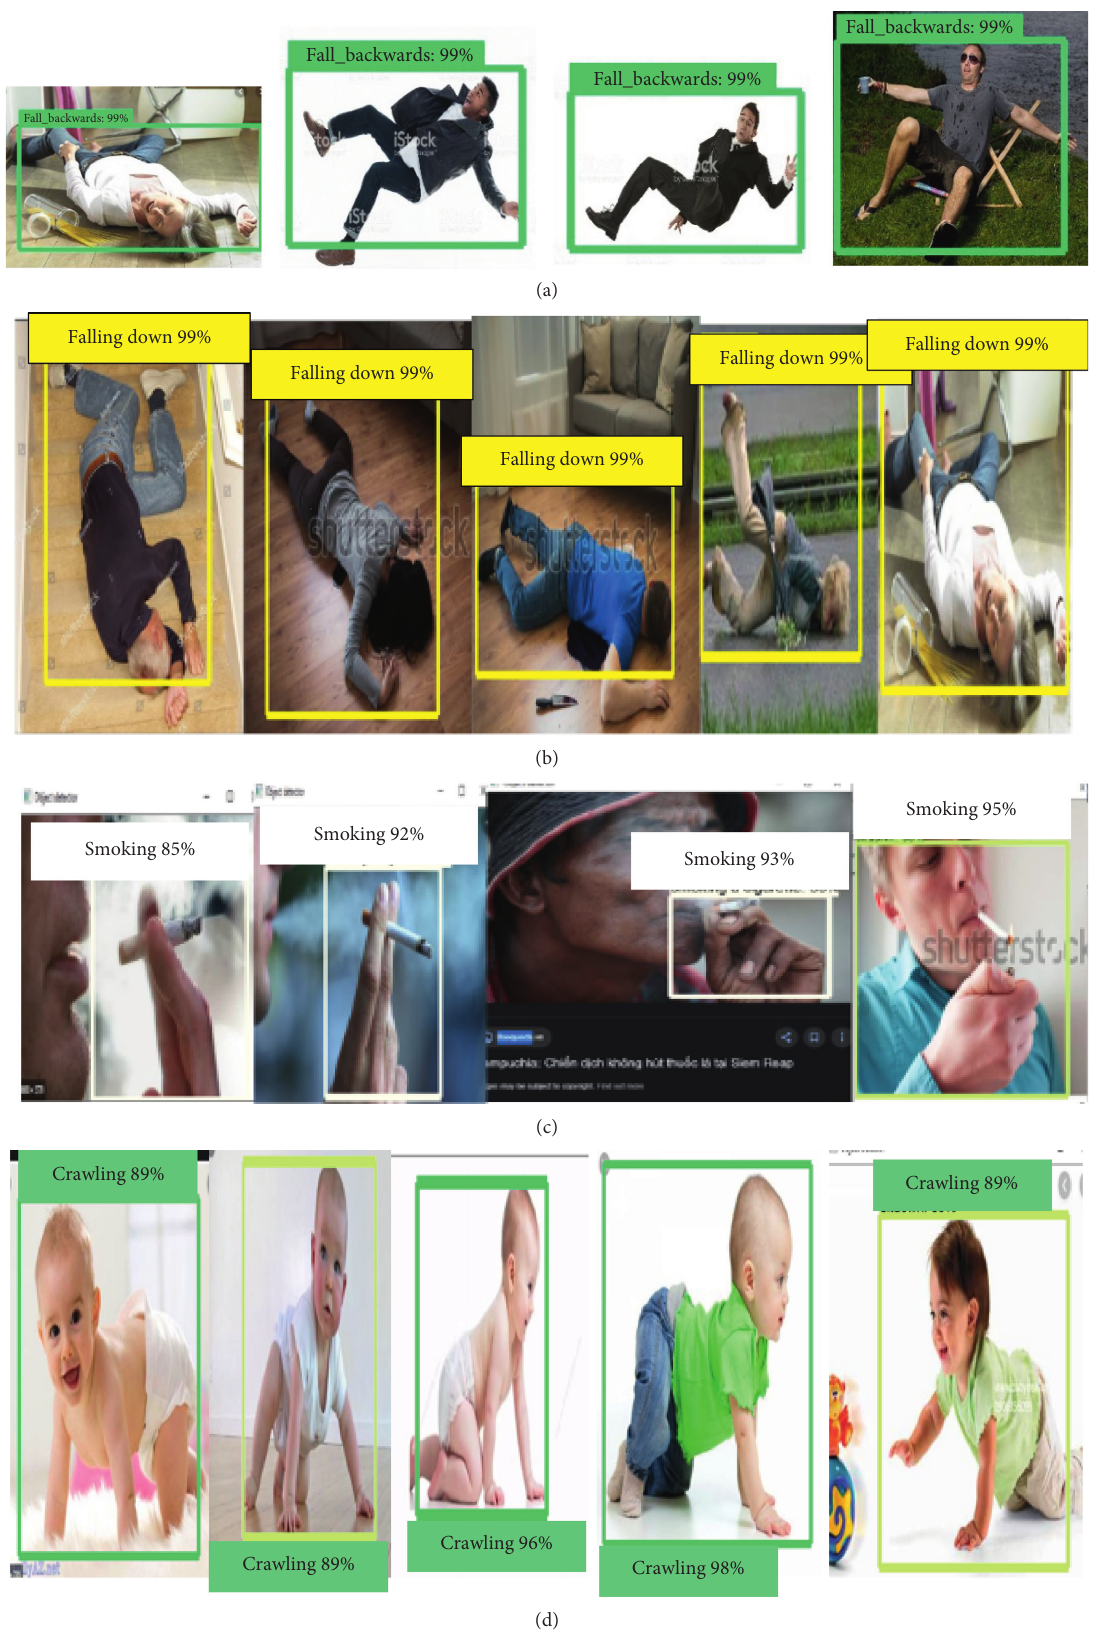
Figure 20: Training results with Tensorflow (RCNN +InceptionV2) for (a) falling back, (b) falling down, (c) smoking, and (d) crawling